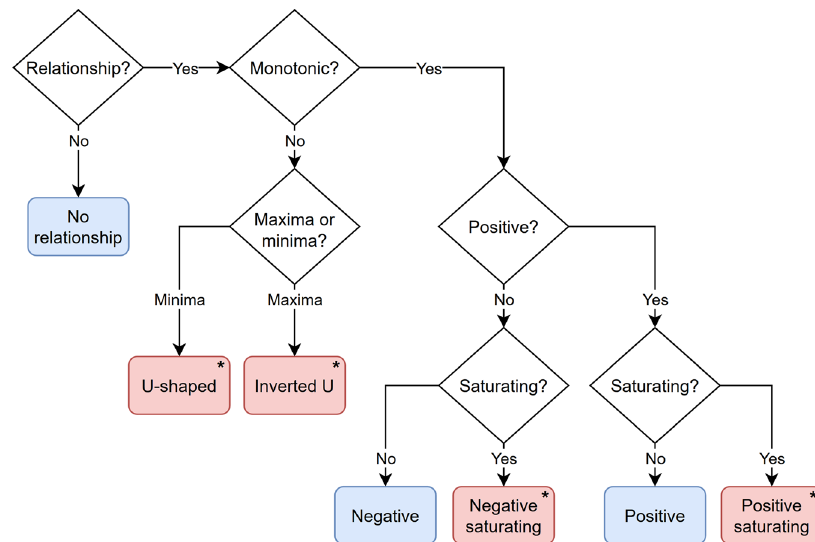
Fig. 4 Dichotomous key to classify the relationship between each modi fi cation indicator and ecosystem service bundle. The relationship between modi fi cation indicator and ecosystem service bundle was visualised using a LOESS regression (Fig. 2), then the regression curve described was classi fi ed with this key. Decoupled relationships are indicated by the red boxes with asterisks.